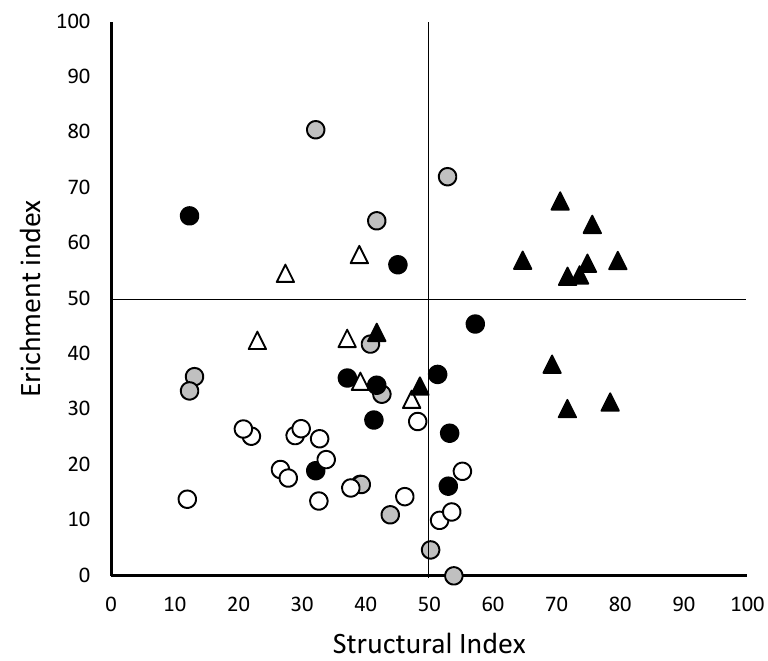
Figure 3. Food web analysis of nematode community assemblages from field A, sampled in 2005 ( ○ ), 2007 ( ) and 2015 ( ● ) and field B sampled in 2005 ( ) and 2015 ( ). The Enrichment index parallels